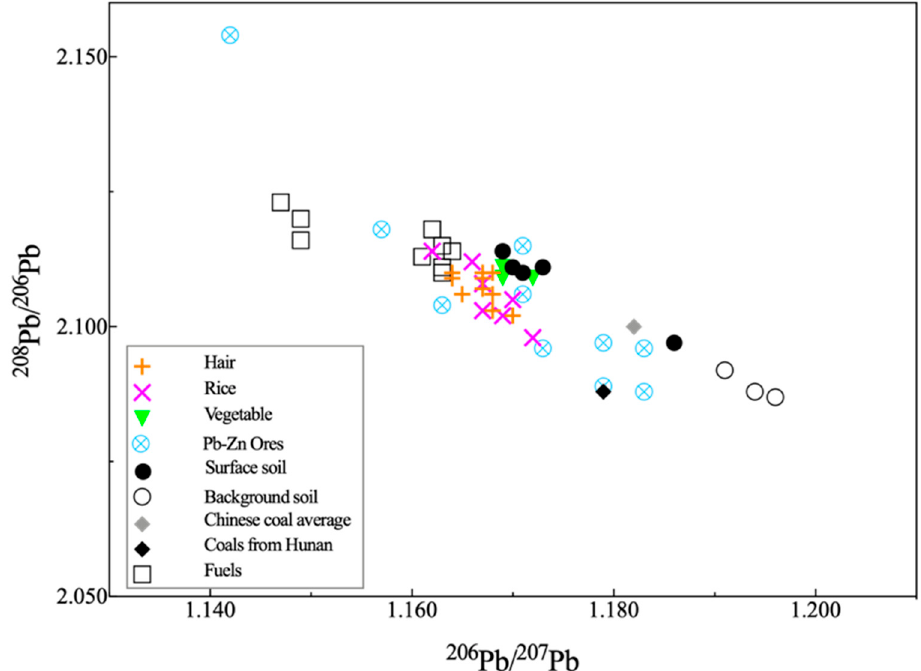
Figure 5. Pb isotopic compositions of rice, vegetable and human hair surrounding the smelter. The data of local coals, Chinese coals, Pb-Zn ores and fuels (gasoline and diesel) were adopted from reference [26]; surface soil and background soil from reference [50].